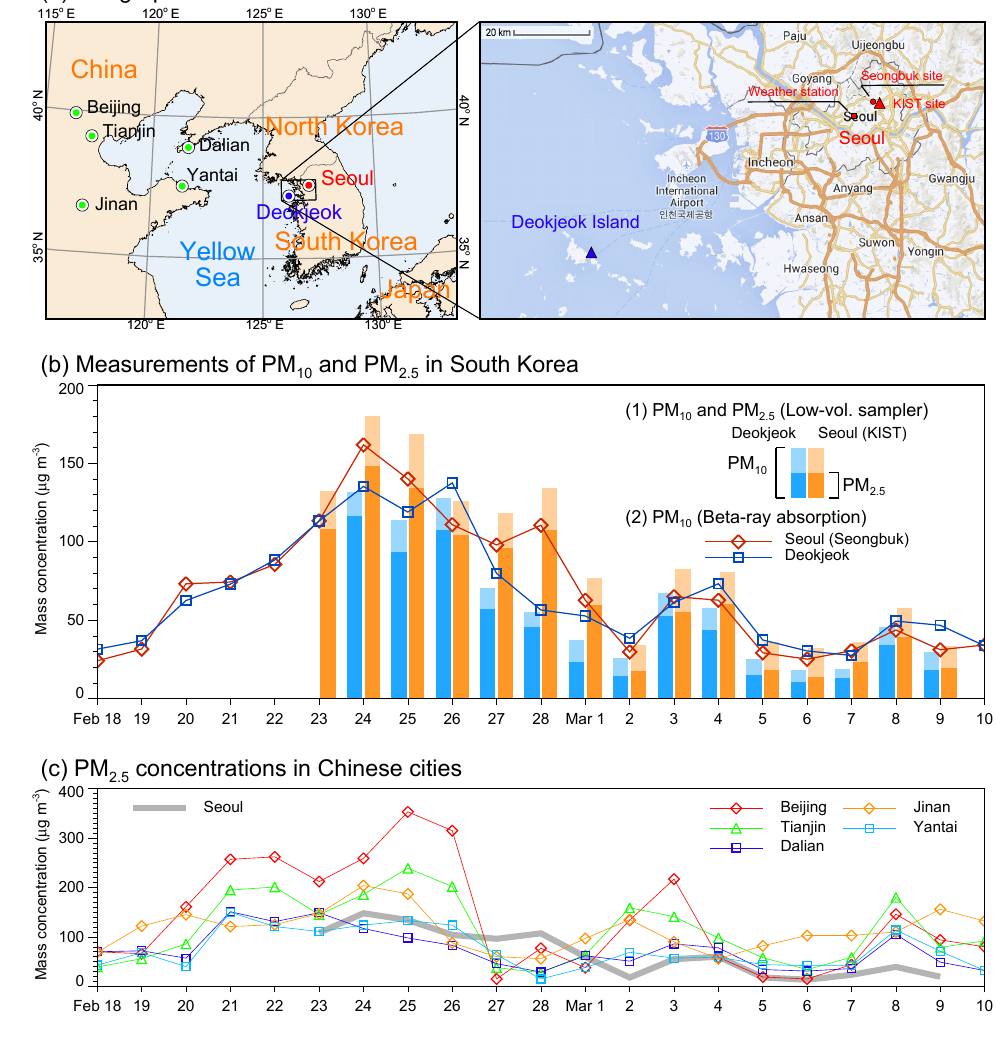
Figure 1. (a) Geographical locations of filter sampling sites (KIST site in Seoul and the Deokjeok site), KMOE air quality monitoring sites (Seongbuk site in Seoul and the Deokjeok site), and KMA weather station in Seoul. (b) Daily mass concentrations of PM 10 and PM 2 . 5 sampled at the KIST site in Seoul and the Deokjeok site (bars) during the multiday haze episode and following the clean period in late February to early March 2014. Red diamonds and blue squares with solid lines denote 24h averages of PM 10 concentration measured by beta-ray absorption at the Seongbuk site in Seoul and at the Deokjeok site, respectively. (c) Daily PM 2 . 5 concentrations in the five Chinese cities of Beijing, Tianjin, Dalian, Jinan, and Yantai (http://www.tianqihoubao.com/aqi/).